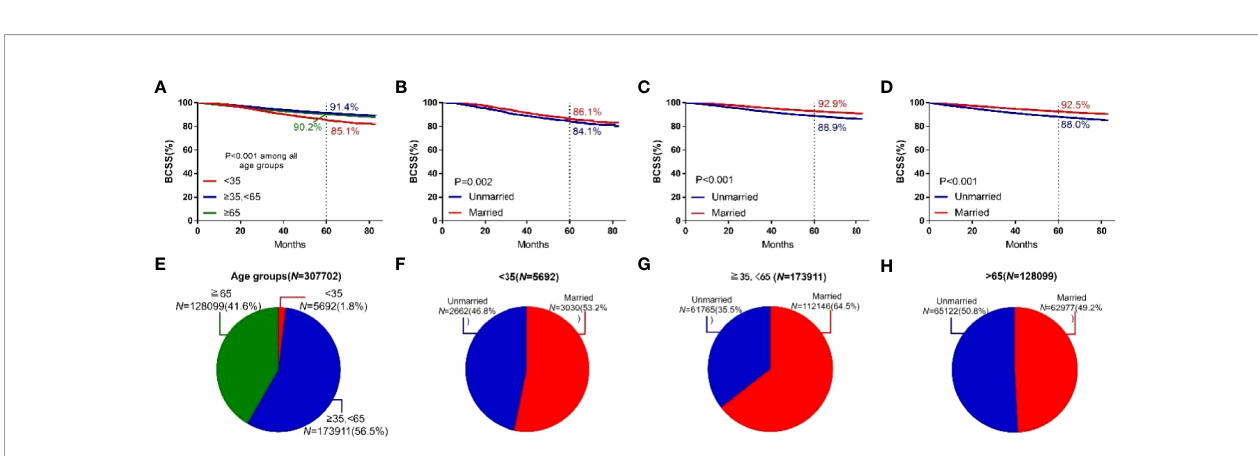
FIGURE 3 | BCSS curves according to the sex groups. (A) and subject proportions of the sex groups (D) . Survival curves of each marital status for female (B) and male (C) and subject proportions of each marital status for female (E) and male (F) were depicted.